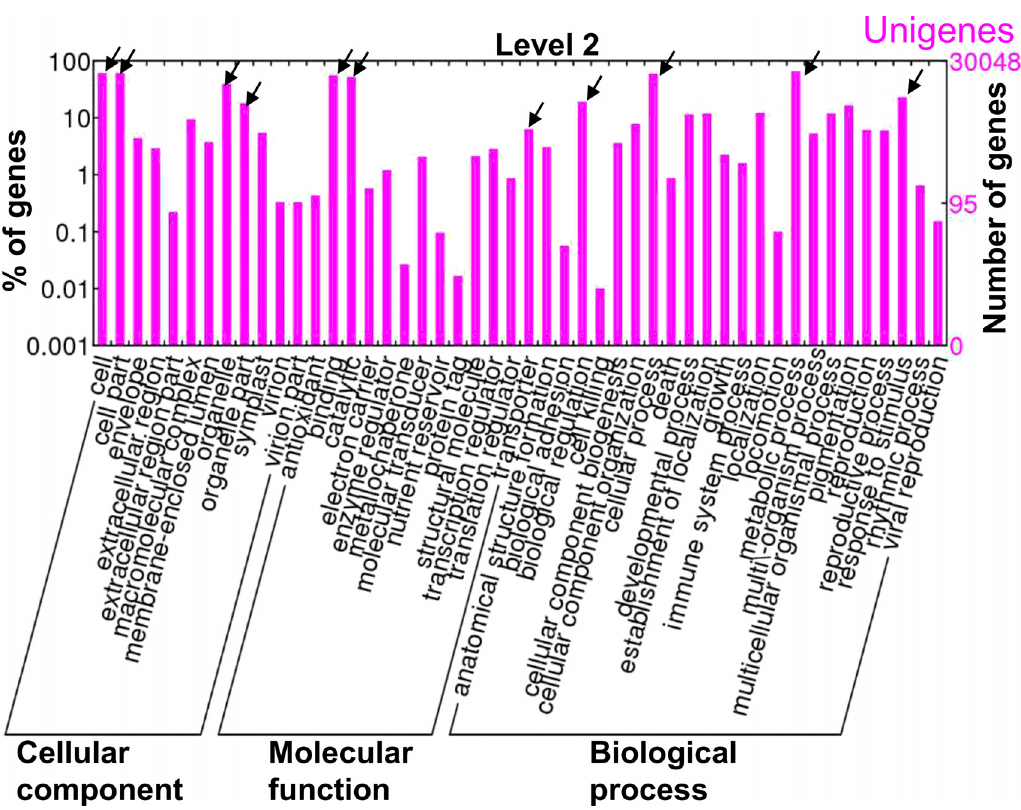
Fig 3. Gene ontology assignments for all assembled unigenes in red perilla. The results are summarized in terms of three functional categories: cellular component, molecular function, and biological process. 30,048 unigenes were categorized by GO terms. The GO terms were visualized using WEGO (http:// wego.genomics.org.cn)